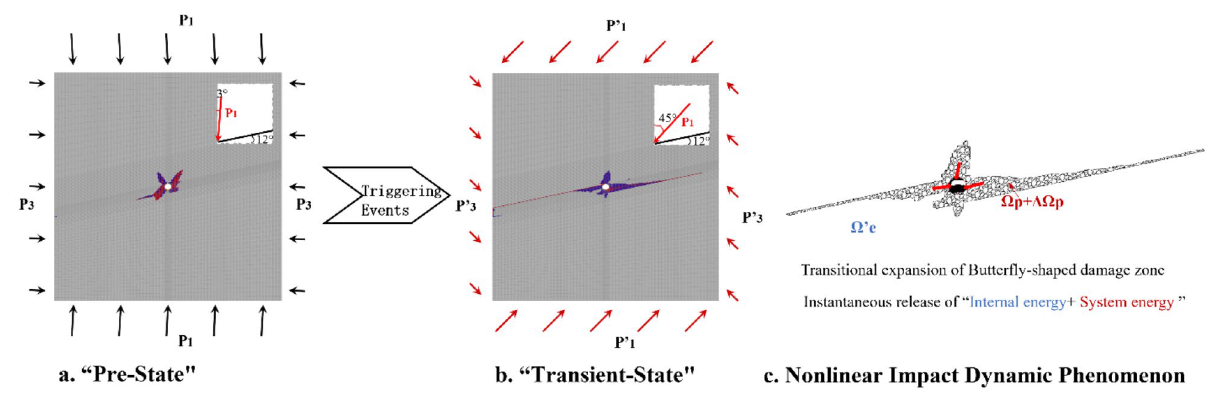
Fig. 12 Physical analysis model of rockburst mechanism in the mining roadway